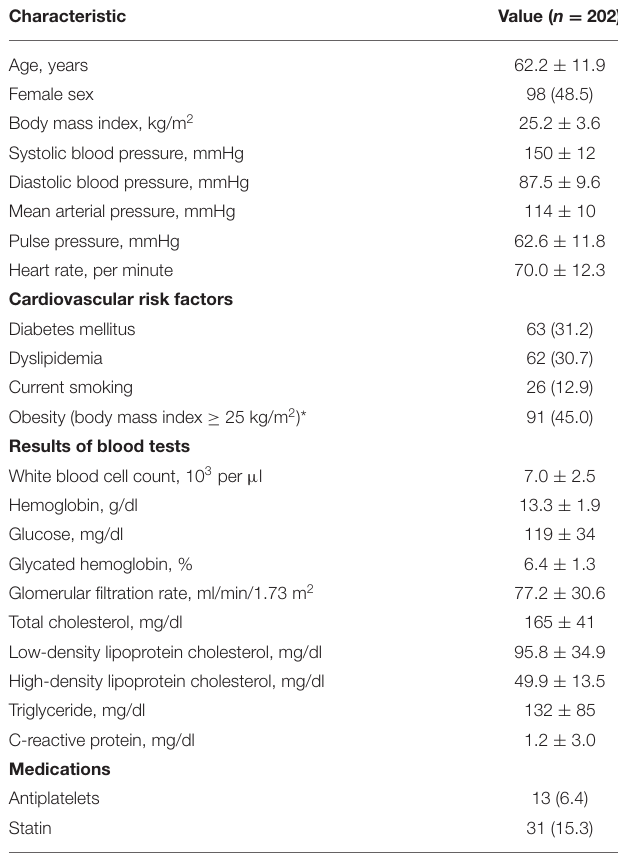
TABLE 1 | Clinical characteristics of study